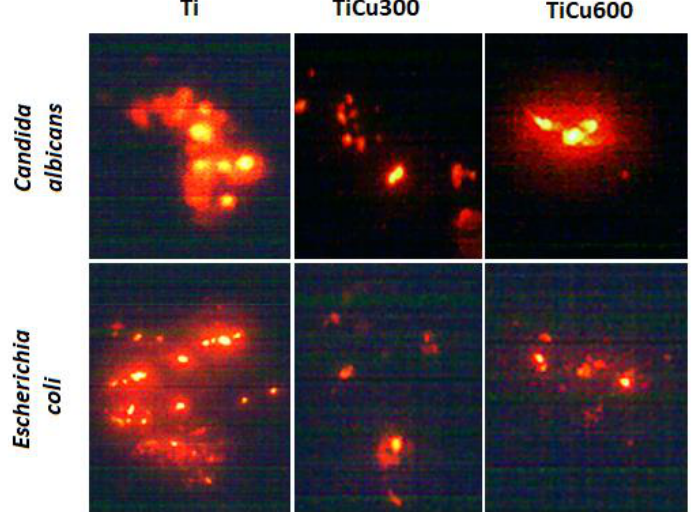
Figure 10. Example fields of adhered cells to reference sample (titanium) and fabricated coatings. Materials 2019 , 12 , x FOR PEER REVIEW